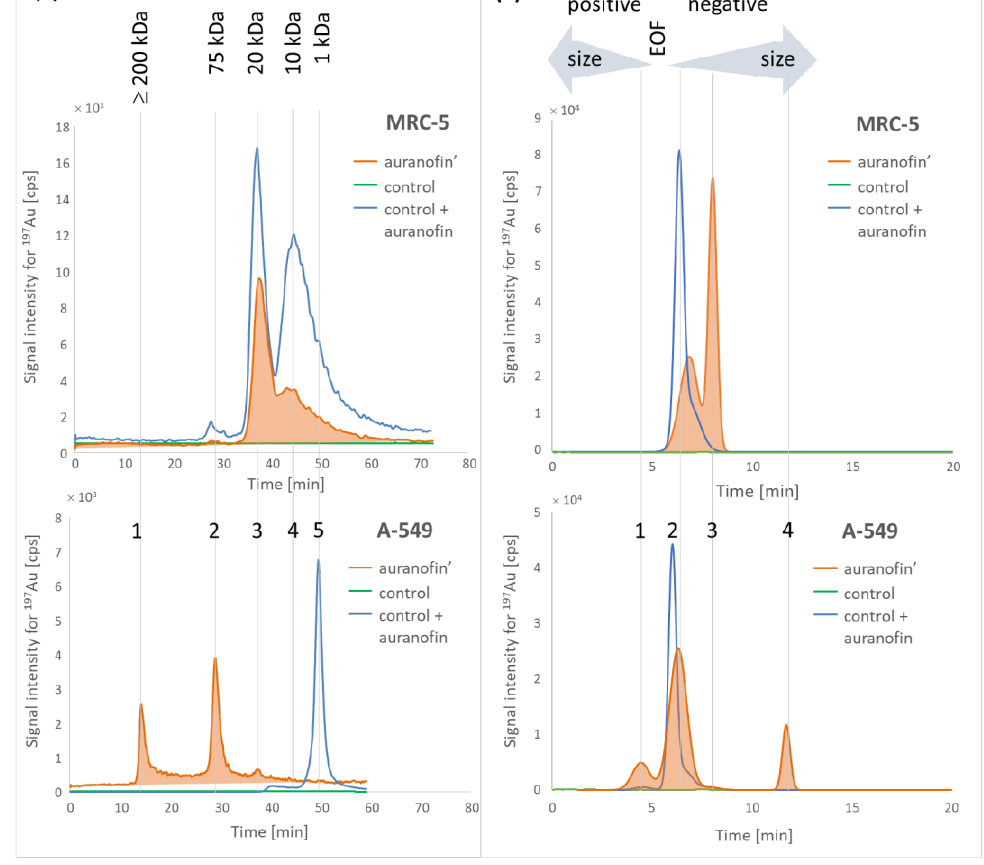
Figure 3. Chromatograms ( a ) and electropherograms ( b ) obtained for lysates of MRC-5 and A-549 cells exposed to 0.6 µM auranofin (auranofin’) for the control group (control) and control group spiked with 0.03 µM of auranofin and incubated for 72 h (control + auranofin).